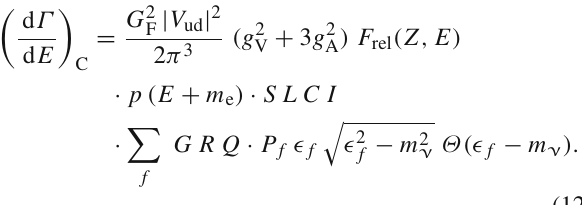
the energy-dependent, higher-order correction terms is given in Sect.